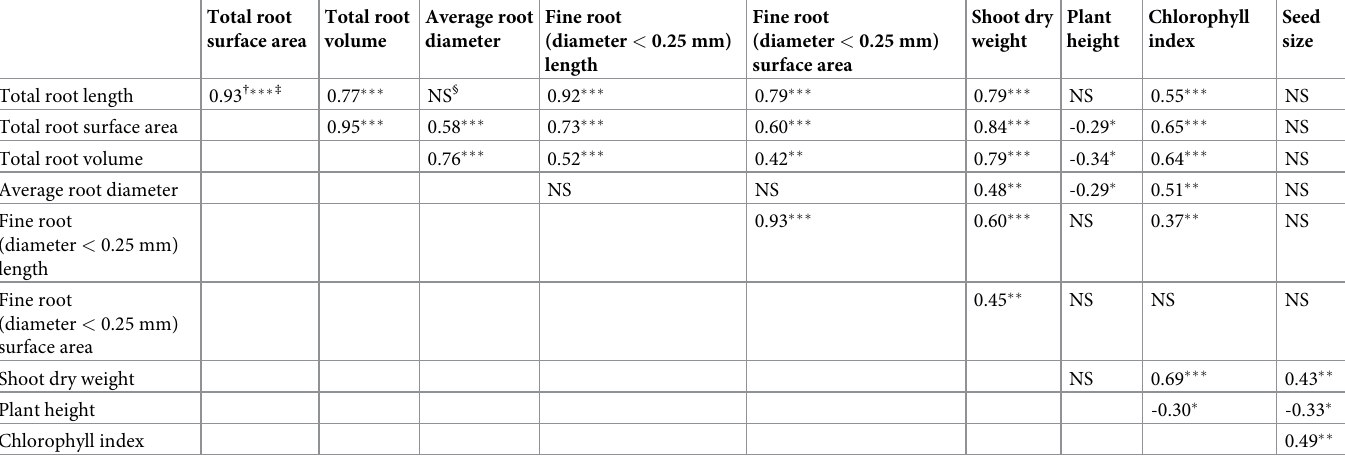
Table 5. Correlations among various root and shoot traits of the 49 soybean genotypes. Total root Total root surface area